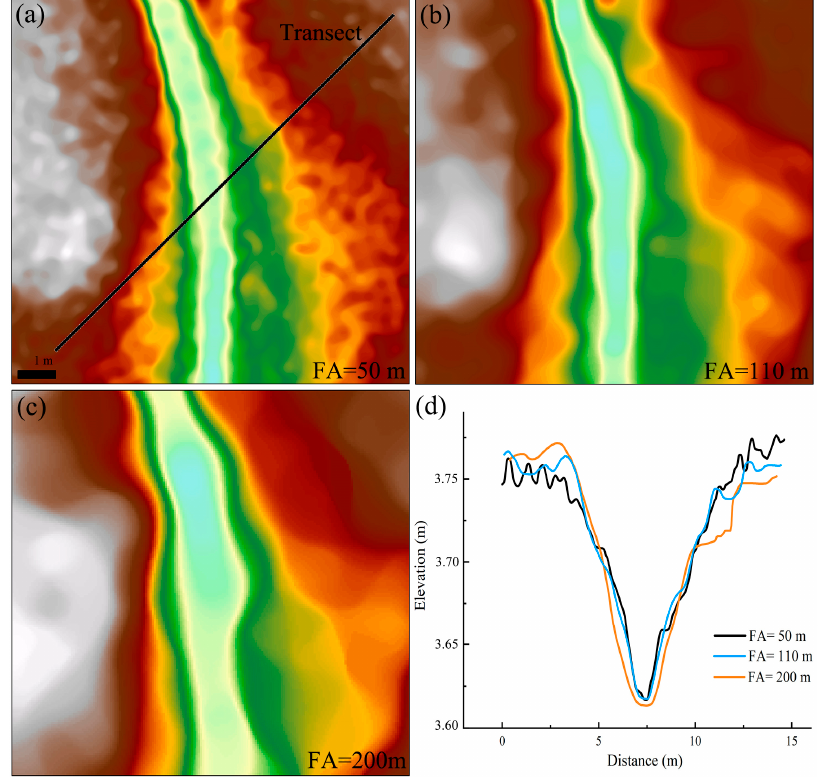
Figure 11. The DEMs generated by different UAV flight altitudes: ( a ) 50 m; ( b ) 110 m; ( c ) 200 m; and ( d ) small tidal channel profiles derived from DEMs.